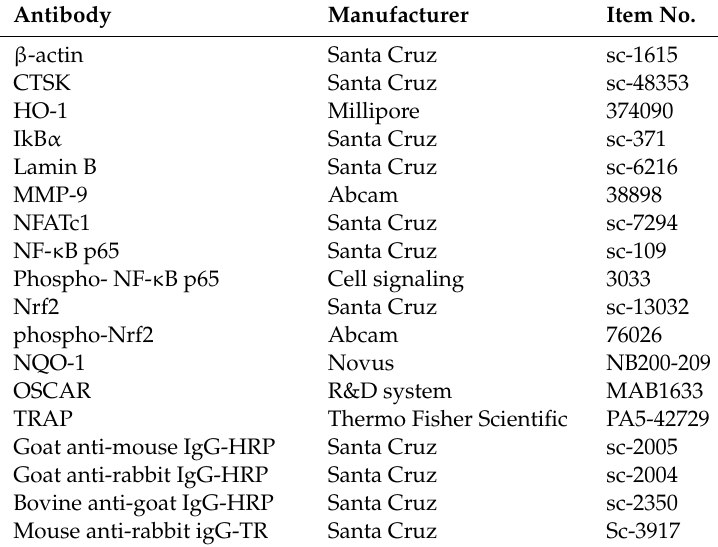
Table 1. Information of primary and secondary